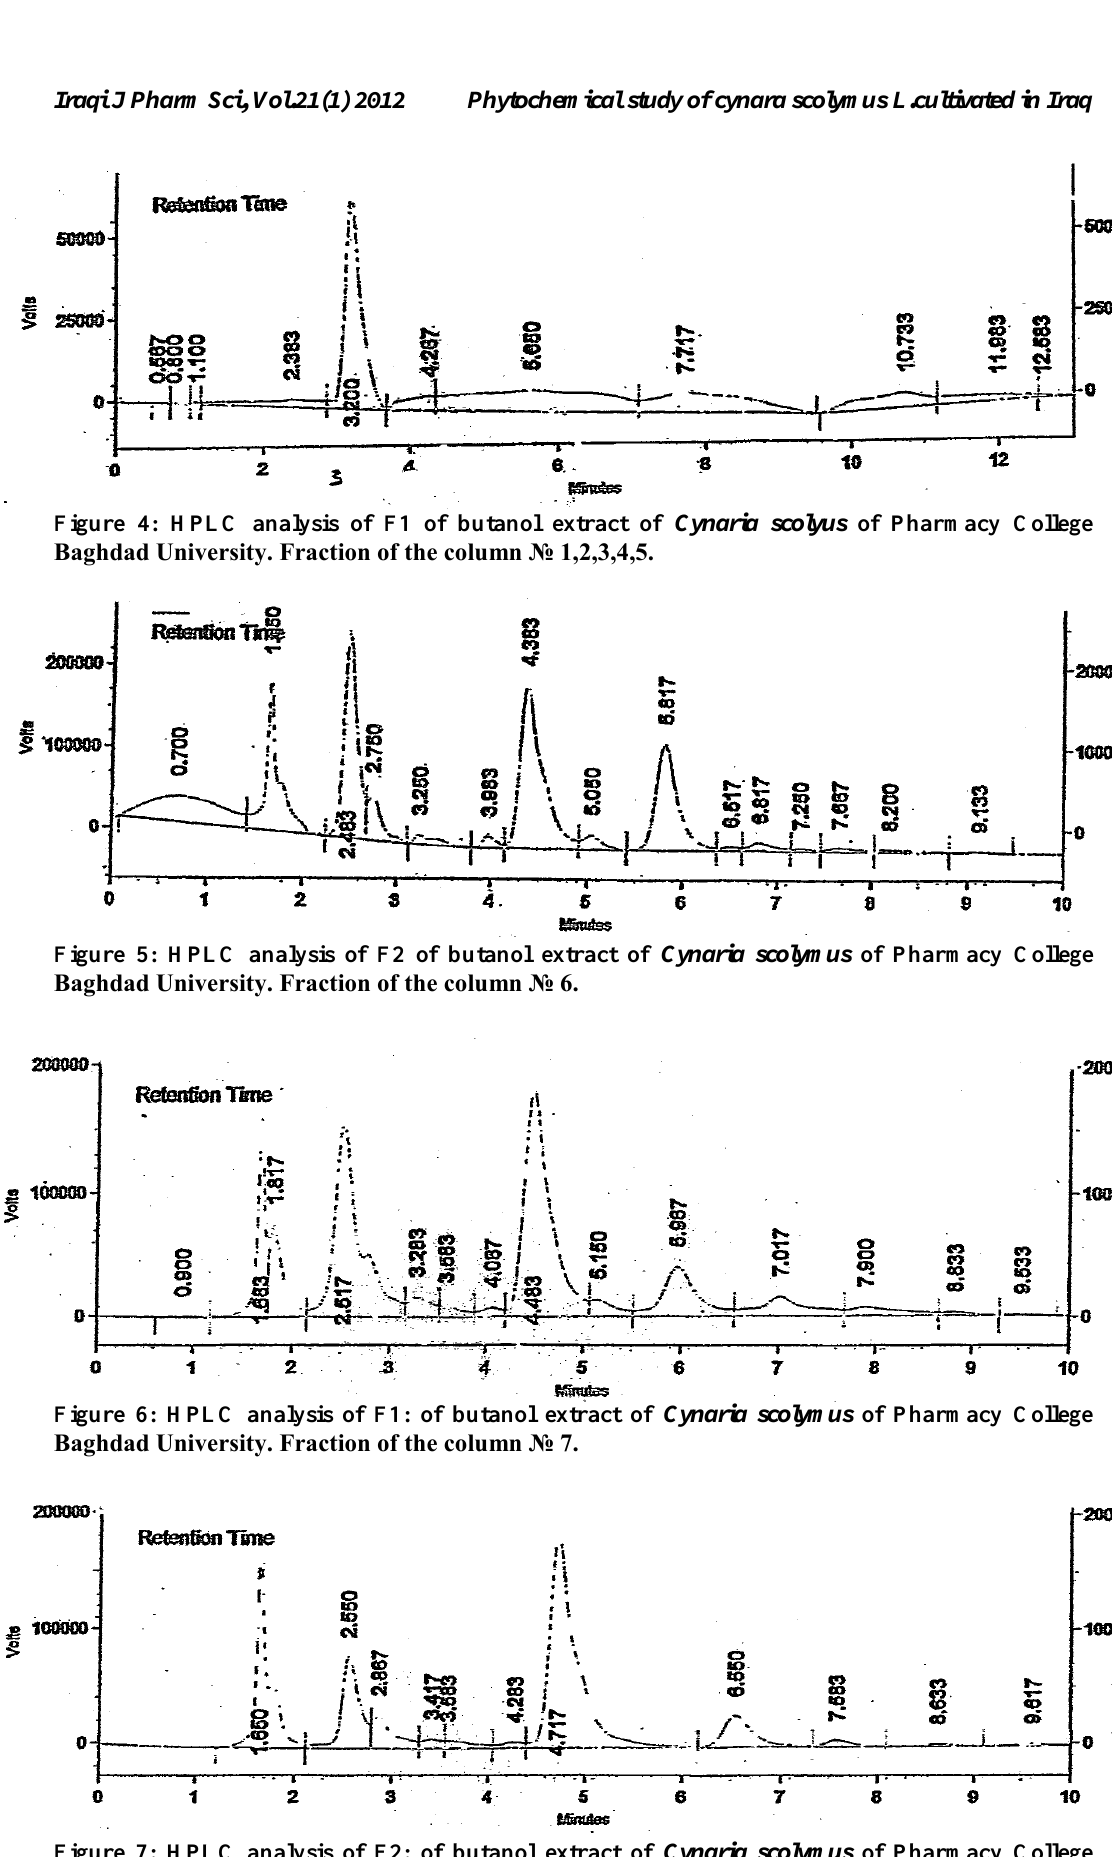
Figure 7: HPLC analysis of F2: of butanol extract of Cynaria scolymus of Pharmacy College Baghdad University. Fraction of the column №